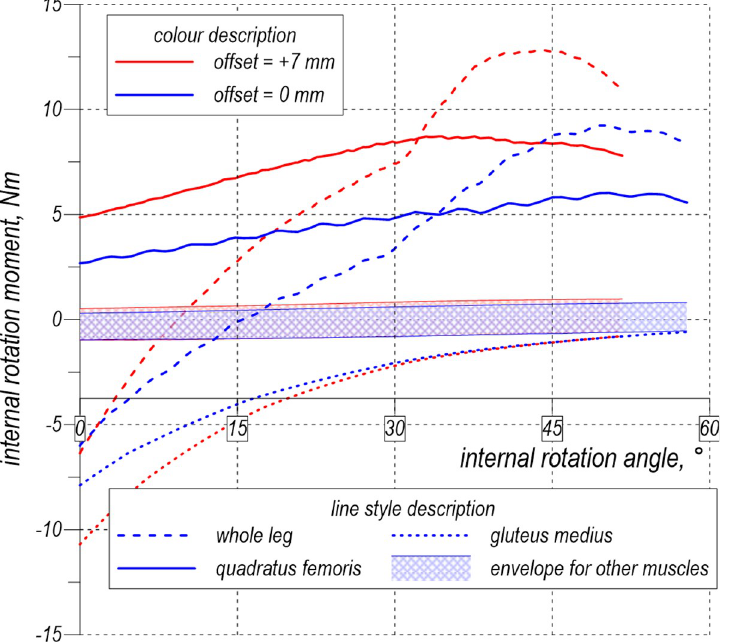
Fig 8. Analysis of the passive internal rotation moment during the intraoperative